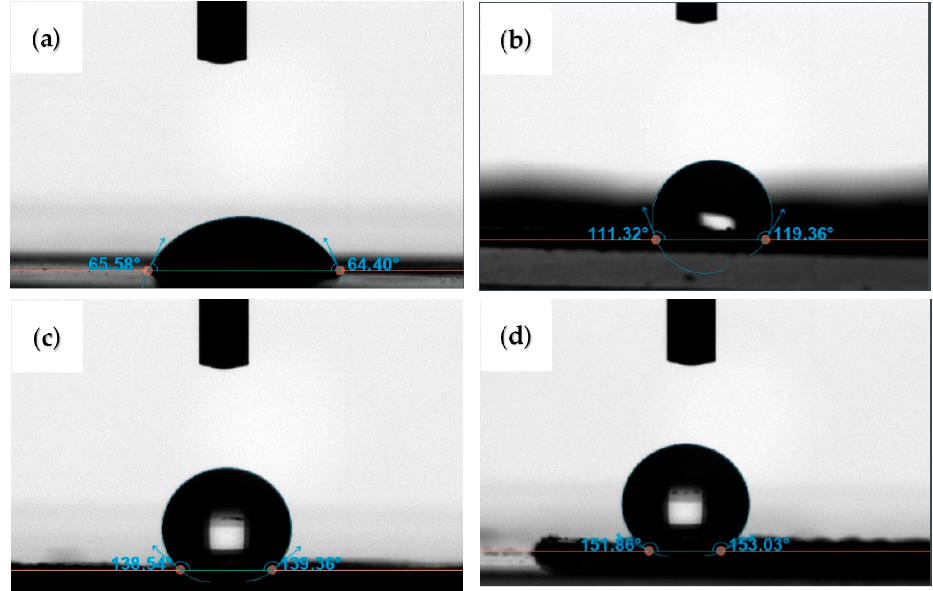
Figure 3. Contact angle measurements made on ( a ) neat PUA film, ( b ) PUA film with negative replica of rose petal structures, ( c ) PUA film with positive replica of rose petal structures, and ( d ) silane treated PUA film with positive replica of rose petal structures.